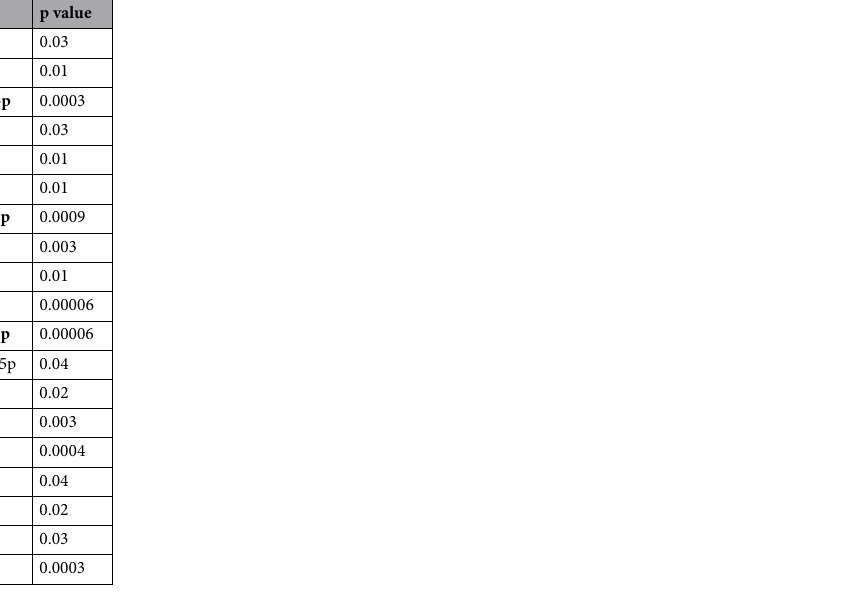
Table 2. 19 miRNAs up- and downregulated according to GLM analysis of sequencing data.